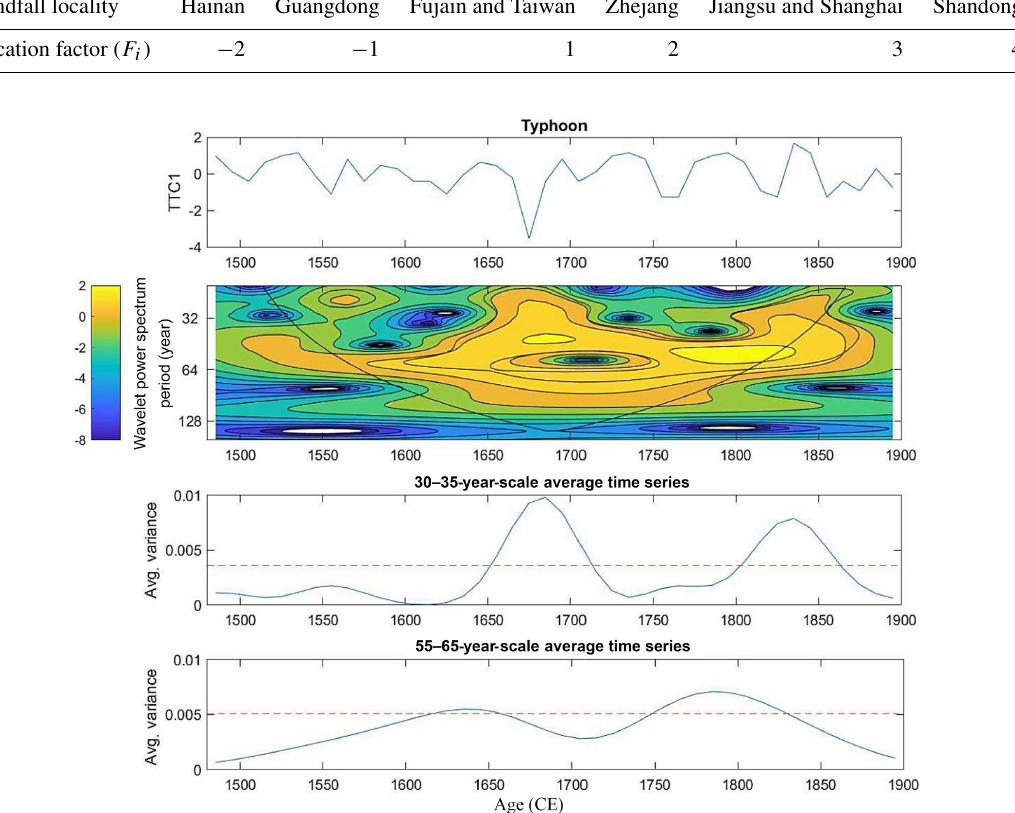
Table 2. Location factor ( F i ) of various geographical locations in China. Landfall locality